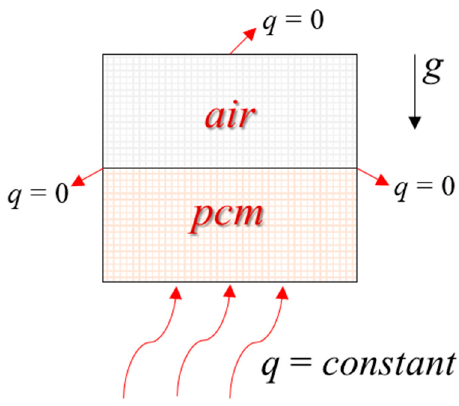
Figure 1. Physical model.